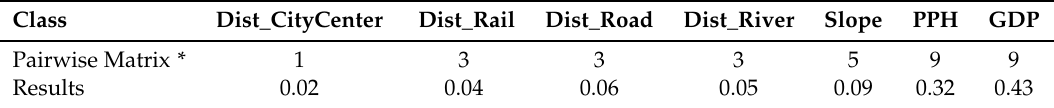
Table 2. Analytical Hierarchical Process (AHP) pairwise matrix.